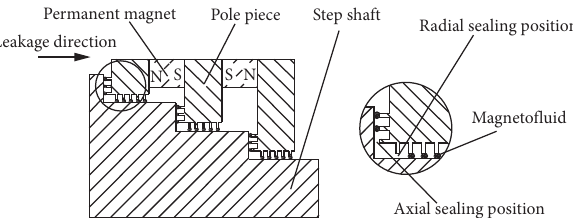
Figure 1: CSMS with small clearance. The enlarged area on the right side of the sketch shows the terms axial and radial seal po- sitions used in the